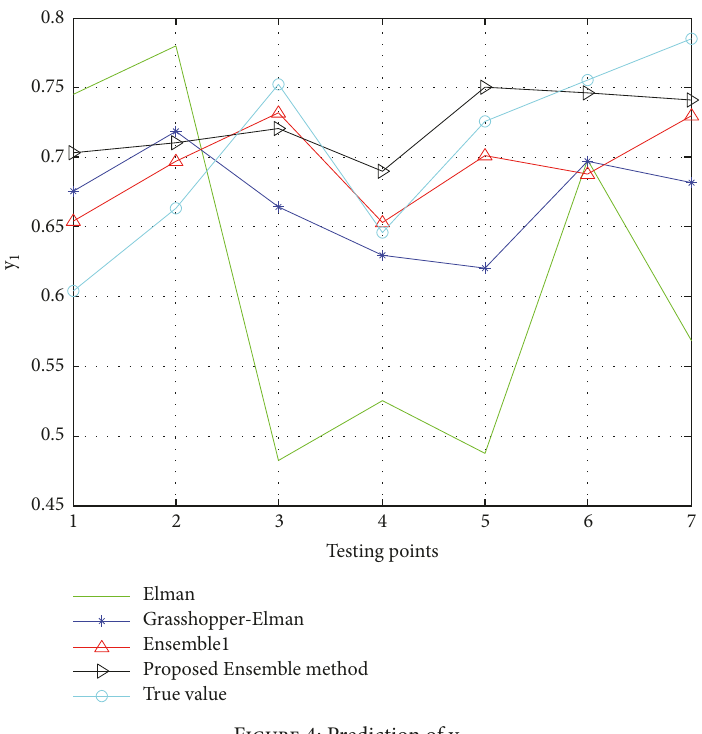
Figure 4: Prediction of y 1 .